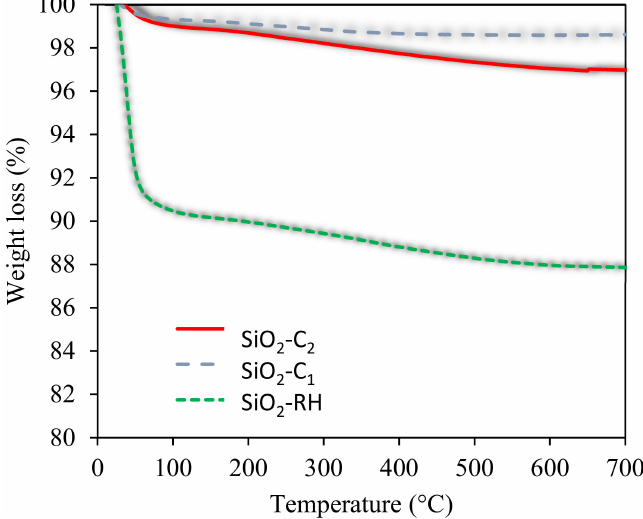
Figure 8. Thermogravimetric analysis (TGA) of silica-based nanoparticles from Sigma-Aldrich (SiO 2 - C 1 ), silica-based nanoparticles in-house synthesized from rice husks (SiO 2 -RH), and commercial silica-based nanoparticles (SiO 2 -C 2